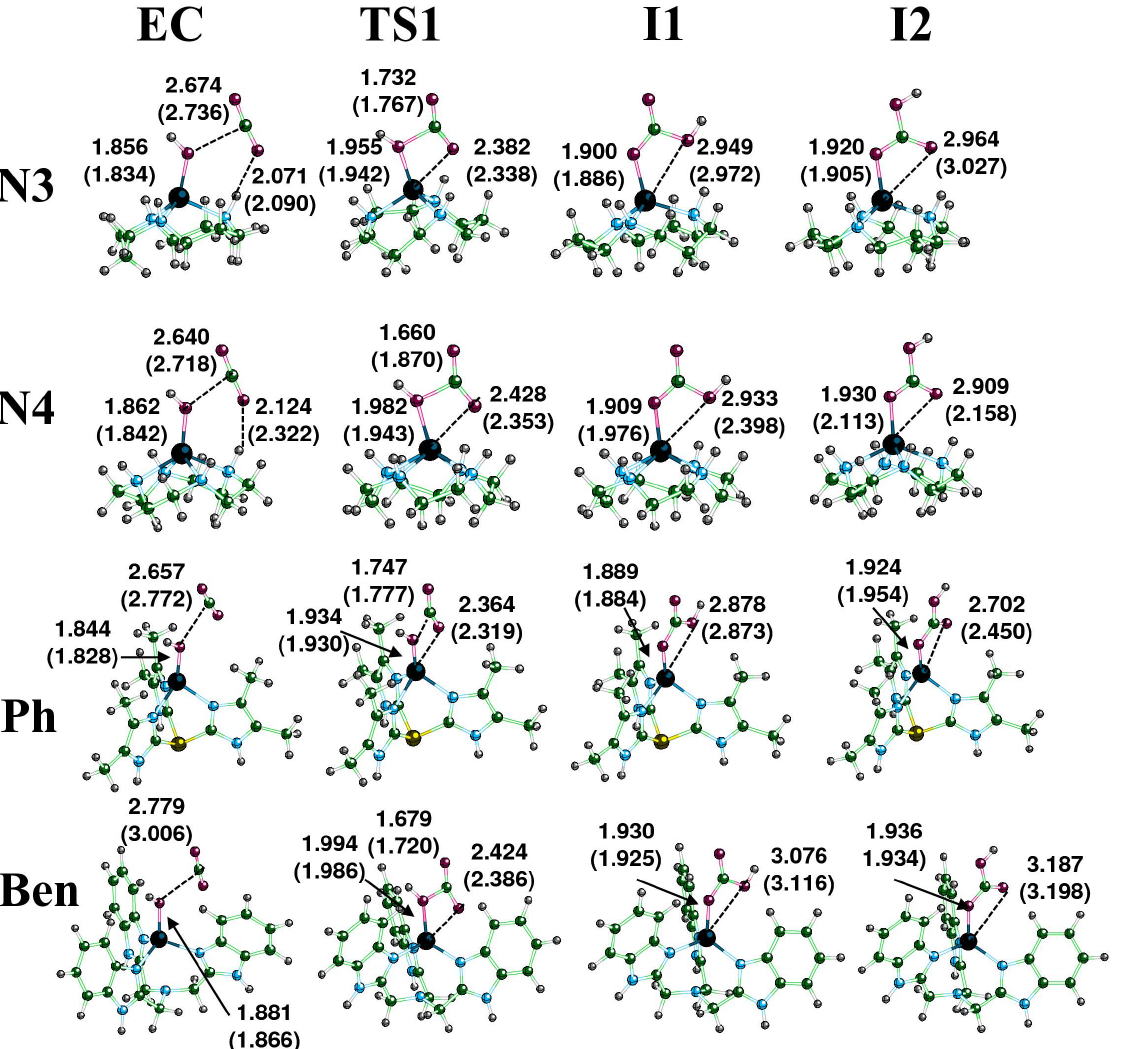
Figure 3. Calculated structures for the zinc complexes of N3, N4, Ph, and Ben complexes during the nucleophilic attack portion of the hydration reaction of CO 2 when forming the encounter complex (EC), first transition state (TS1), Lindskog intermediate (I1), and Lipscomb intermediate (I2). Distances are listed in angstroms and values in the parenthesis are the corresponding distances for the cobalt